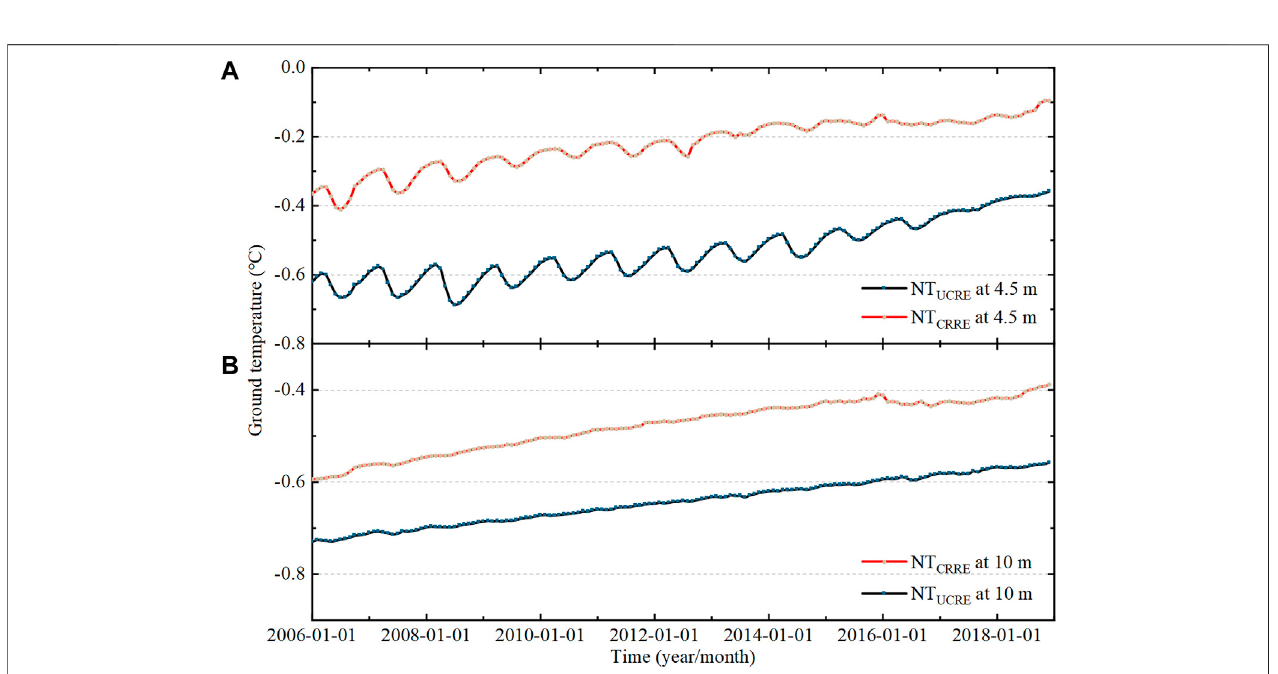
Frontiers in Earth Science |